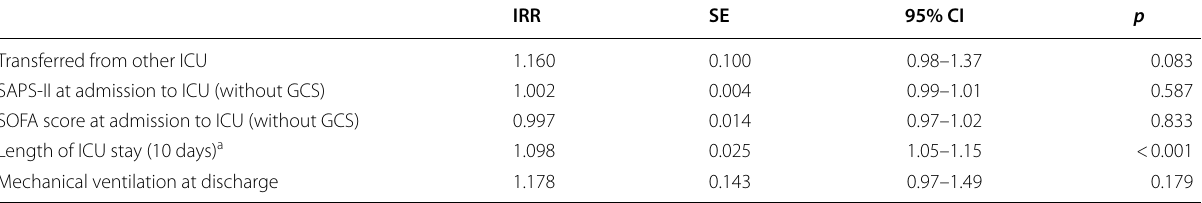
Table 4 Multivariable negative binomial regression analysis of days of hospitalization after discharge from